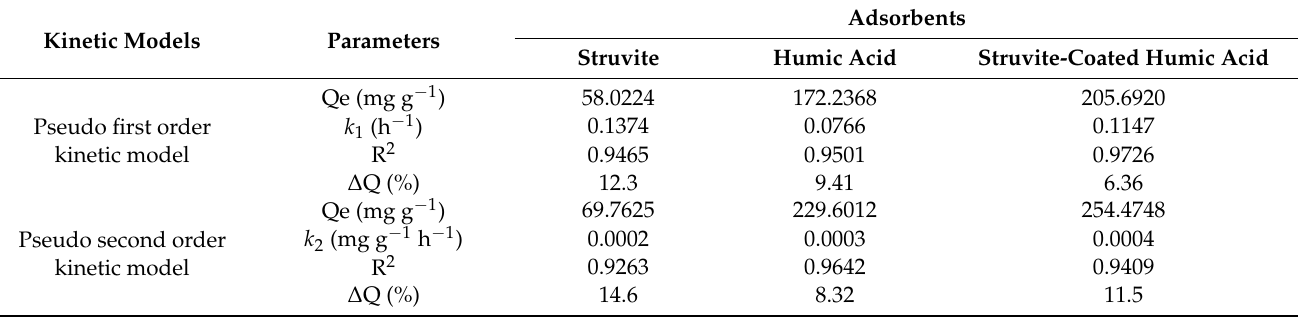
Table 2. The Cr (VI) kinetic data and best-fit parameters of pseudo first- and second-order kinetic